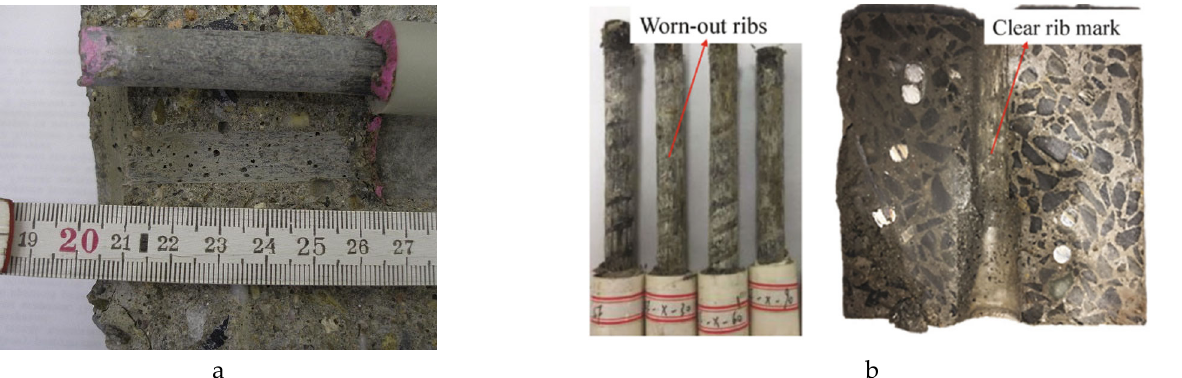
Figure 9. Failure performance of ( a ) GR and ( b ) SFCB in the pull ‐ out test [2,38]. Similarly, epoxy coats can also develop bond strength between concrete and reinforce- ment during corrosion [148]. El-Hawary [149] set specimens in tanks of seawater. With increase in exposure time, the bond strengths of the BSR reinforced specimens decreased faster than those of the ECR reinforced specimens. As shown in Figure 10, after 18 months of exposure in the Gulf, the bond strength in ECR reinforced specimens climbed to 108% of the bond strength in uncoated bar reinforced specimens. This enhancement was attributed to salt crystallization in the concrete pores.